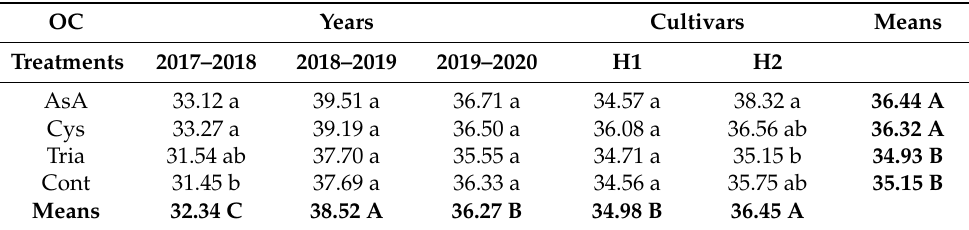
Means 32.34 C 38.52 A 36.27 B 34.98 B 36.45 A